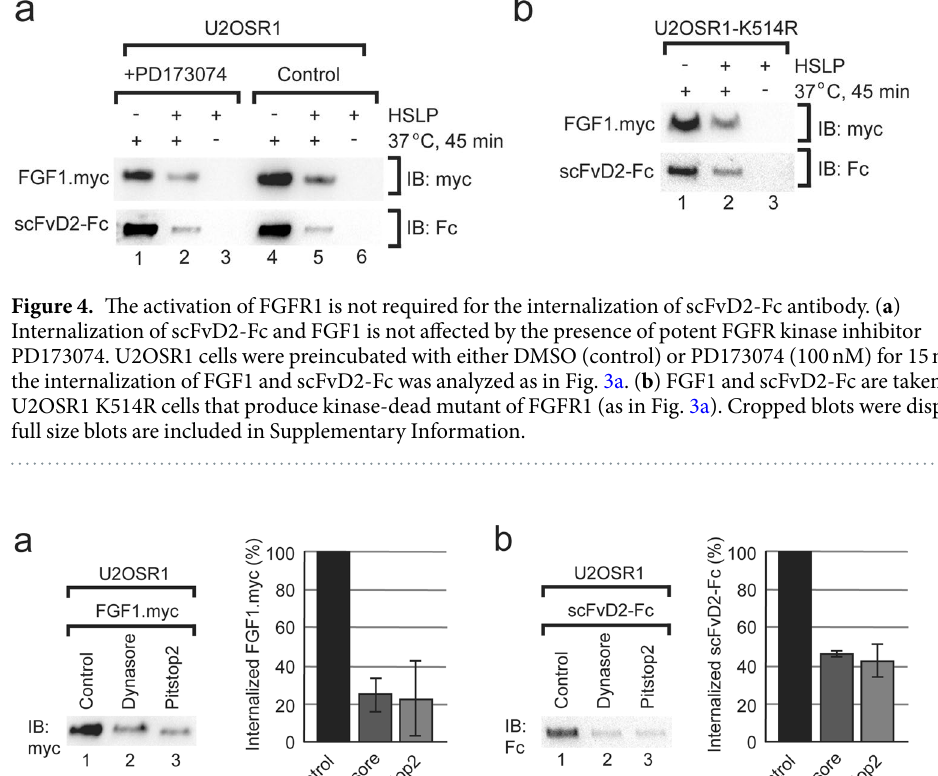
cipitation. The presence of FGF1 led to the efficient formation of high molecular weight species of FGFR1, which